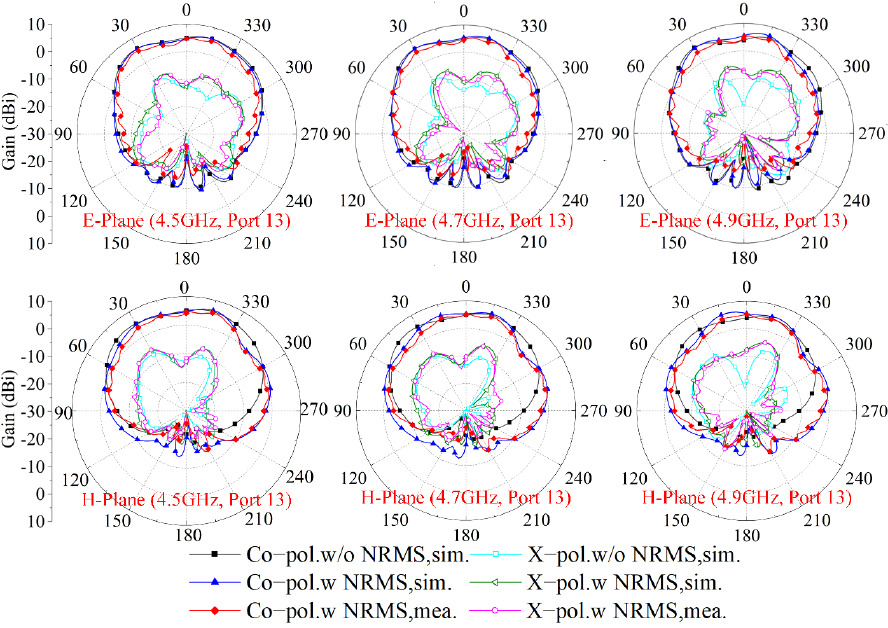
Figure 11. The radiation patterns of the array with and without NRMS at different frequencies.